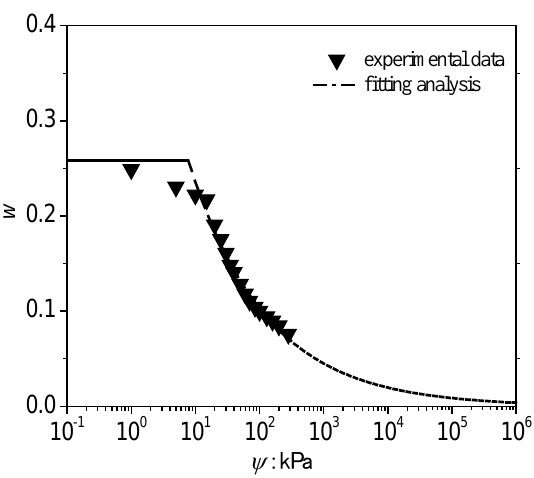
Figure 13. Determination of air-entry values at reference state through fitting Equation (12) to the experimental SWCCs for Saskatchewan silt (T1) with e 0 = 0.692.